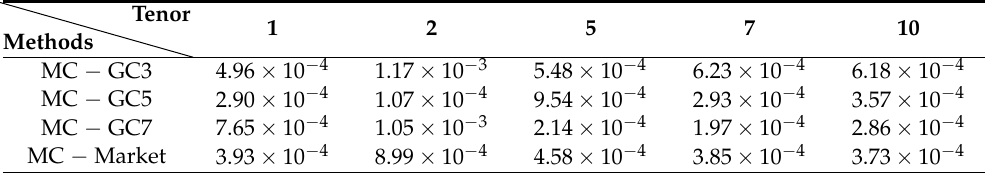
Table 3. Average absolute errors of Monte-Carlo prices compared to Gram–Charlier prices and market prices using the parameters shown in Table 2. Methods